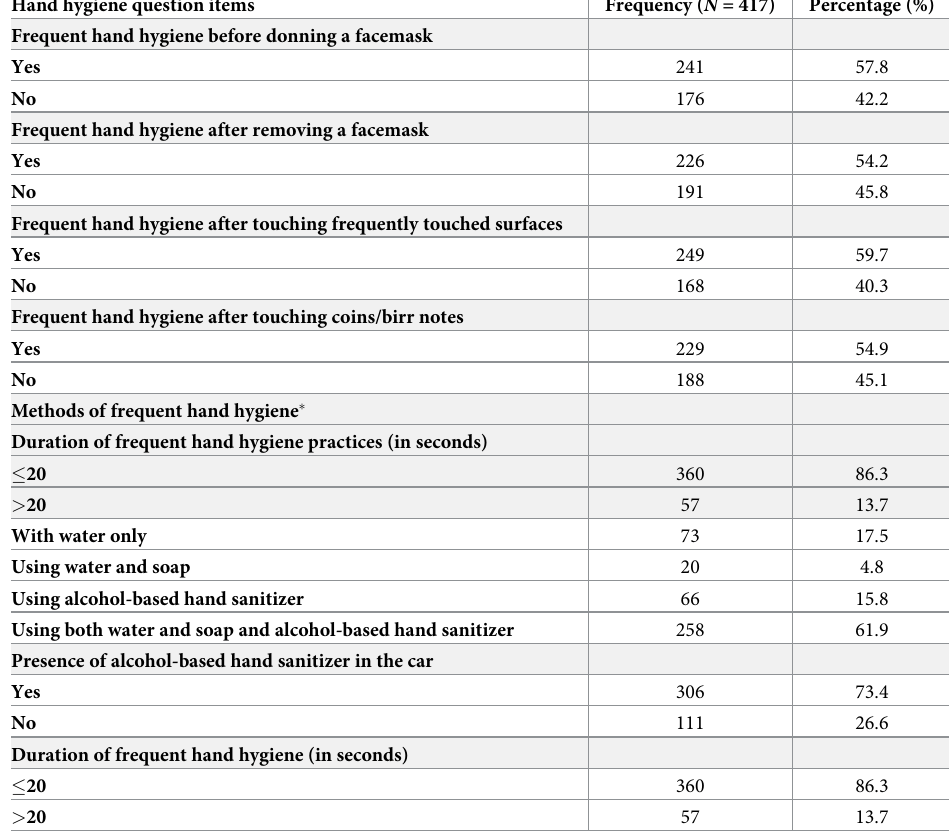
Fig 3. Proportion of good and poor frequent hand hygiene practices towards COVID-19 among taxi drivers in Dessie City and Kombolcha Town, Ethiopia, July to August 2020. https://doi.org/10.1371/journal.pone.0253452.g003 Table 4. Hand hygiene practices using clean water and soap or alcohol-based hand sanitizer among taxi drivers in Dessie City and Kombolcha Town, Ethiopia, July to August 2020. Hand hygiene question